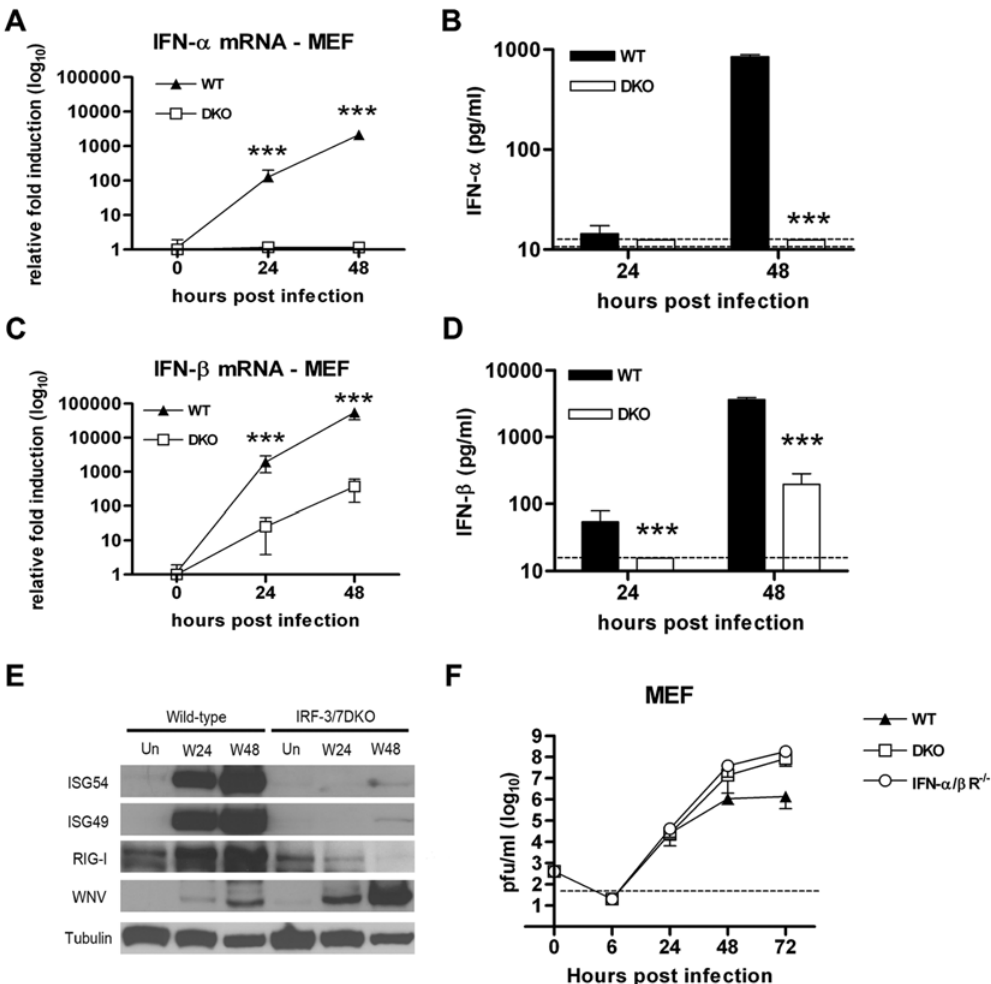
Figure 3. IRF-3 and IRF-7 control the IFN- a / b gene induction and ISG expression in MEF. A–D . MEF generated from wild type or DKO mice were infected at an MOI of 0.1 and analyzed for IFN- a / b gene induction. Total RNA from uninfected and WNV-infected MEF was harvested at the indicated times after infection and levels of ( A ) IFN- a and ( C ) IFN- b mRNA were measured by qRT-PCR. Data are normalized to 18S rRNA and are expressed as the relative fold increase over normalized RNA from uninfected controls. Accumulation of ( B ) IFN- a and ( D ) IFN- b protein in supernatants was evaluated by ELISA. E . Whole cell lysates were generated at the indicated times from wild type or DKO MEF that were uninfected (Un) or infected with WNV (W). Protein levels of ISG49, ISG54, RIG-I, WNV and tubulin were examined by immunoblot analysis. F . MEF generated from wild type, IFN- ab R 2 / 2 and DKO mice were infected at an MOI of 0.001 and virus production was evaluated by plaque assay. The data is the average of at least three independent experiments performed in quadruplicate, (***, P ,